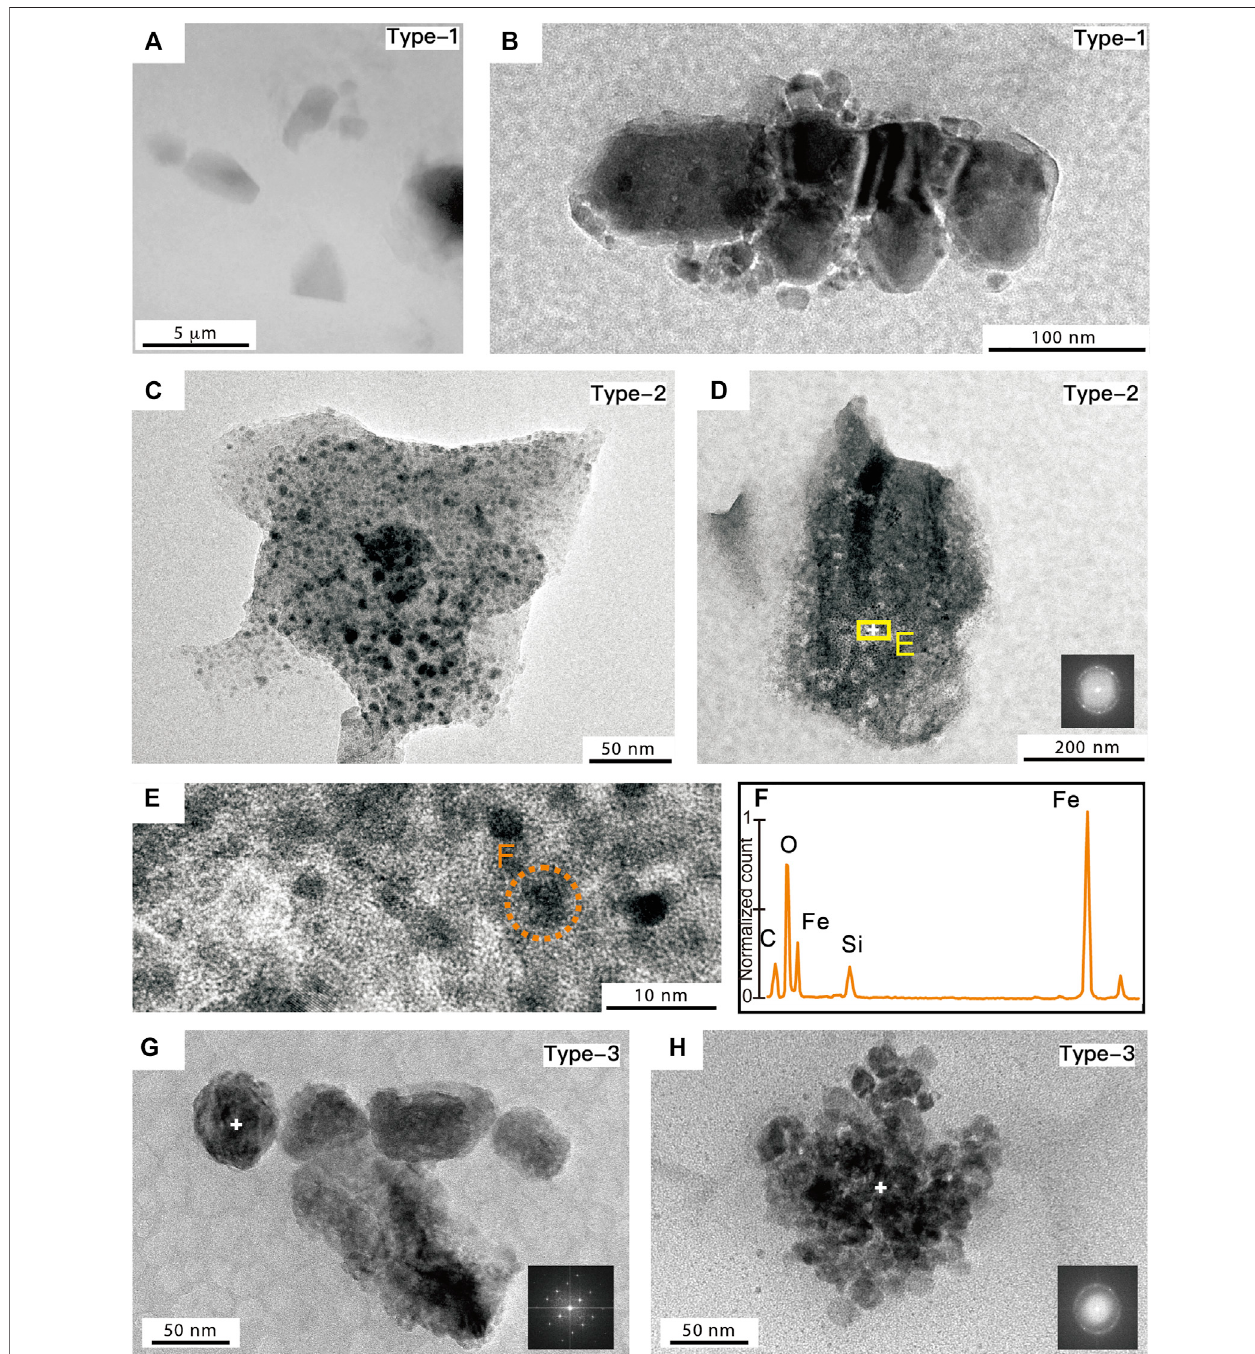
FIGURE 5 | Images of microscopy observation of ferromagnetic particles extracted from one sample at depth of 628 cm (118 ka, MIS 5e). (A) Coarser particles ( ∼ 0.5 – 5 μ m) canbeobservedbysynchrotron TransmissionX-rayMicroscope.Thosegrainsareangularinshape. (B) ImageofTransmission Electron Microscope(TEM) presents fi ne extracted-magnetic particles ( ∼ 50 – 100 nm) in irregular shapes. (C – D) Silicate-hosted ferromagnetic minerals, represented by abundant nano-sized ( < 15 nm) inclusions of ferromagnetic grains embedded within silicates with angular morphology. (E) Enlargement image of (D) presents nano-sized ( < 10 nm) inclusions.TheSelectedAreaElectronDiffraction(SAED)patternofthoseinclusionspresentssigni fi cantcrystaldefects. (F) Energy-DispersiveX-raySpectroscopy(EDS) analysisofselectedareain (E) revealsthatthoseinclusionscontainabundantFeandO. (G) Imageofnanometerferromagneticaggregates( ∼ 50 – 100 nm)showingsingle crystals with signi fi cant crystal defects. (H) Image of smaller nanometer-sized ferromagnetic aggregates (a few nm to ∼ 20 nm) reveals randomly oriented single crystals. The type of each ferromagnetic particle is speci fi ed in each photo; see text for further explanations.